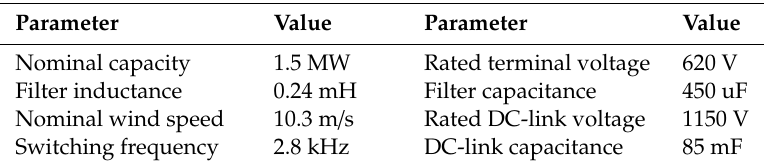
Figure 2. Configuration of the permanent magnet synchronous generator (PMSG)-based wind turbine generators (WTG). Table 2. Parameters of the test WTG system.